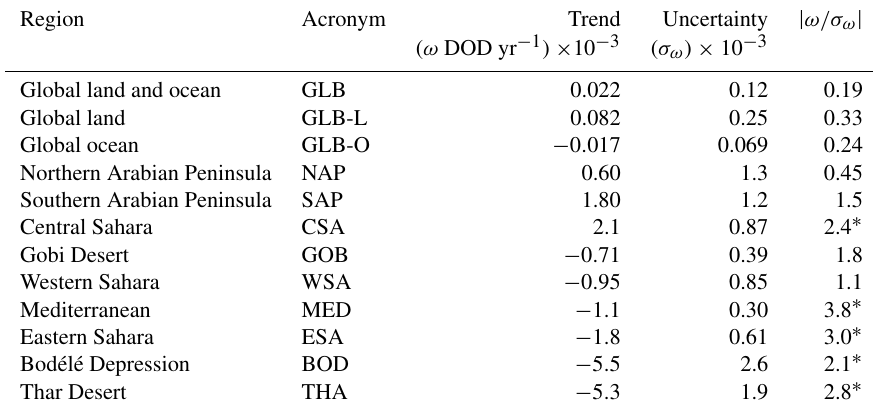
Table 3. Global and regional temporal DOD trends based on the MIDAS dataset. The trends with the ratio | ω/σ ω | higher than 2.0 are statistically significant at the 95% confidence level. The star symbol corresponds to statistically significant regions under the 95% confidence level. The domains of the regions are represented in Fig. 7.